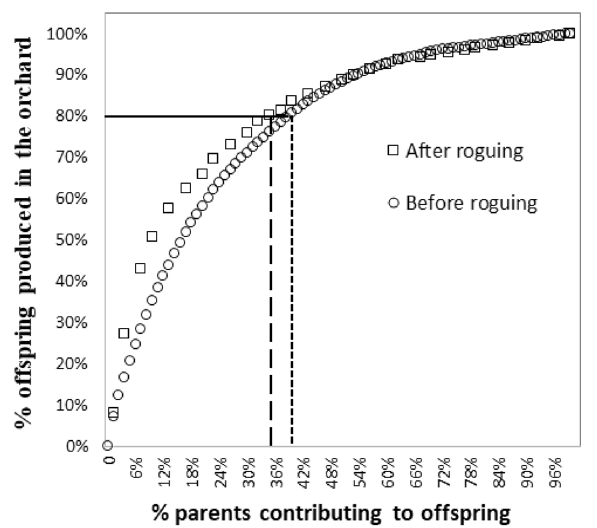
Figure 2. Cumulative reproductive success in the G1 white spruce clonal seed orchard obtained using pedigree reconstruction with genomic profiles with a set of 2000 SNPs. Circles represent the reproductive success rate of 151 parents over 420 offspring from five seedlots obtained before roguing the orchard. Squares represent the reproductive success rate of 53 parents over 105 offspring from 1 seedlot obtained after roguing the orchard. The line represents 80% of the offspring produced in the orchard, corresponding to a % parents before (short dashed lines) and after (long dashed lines)